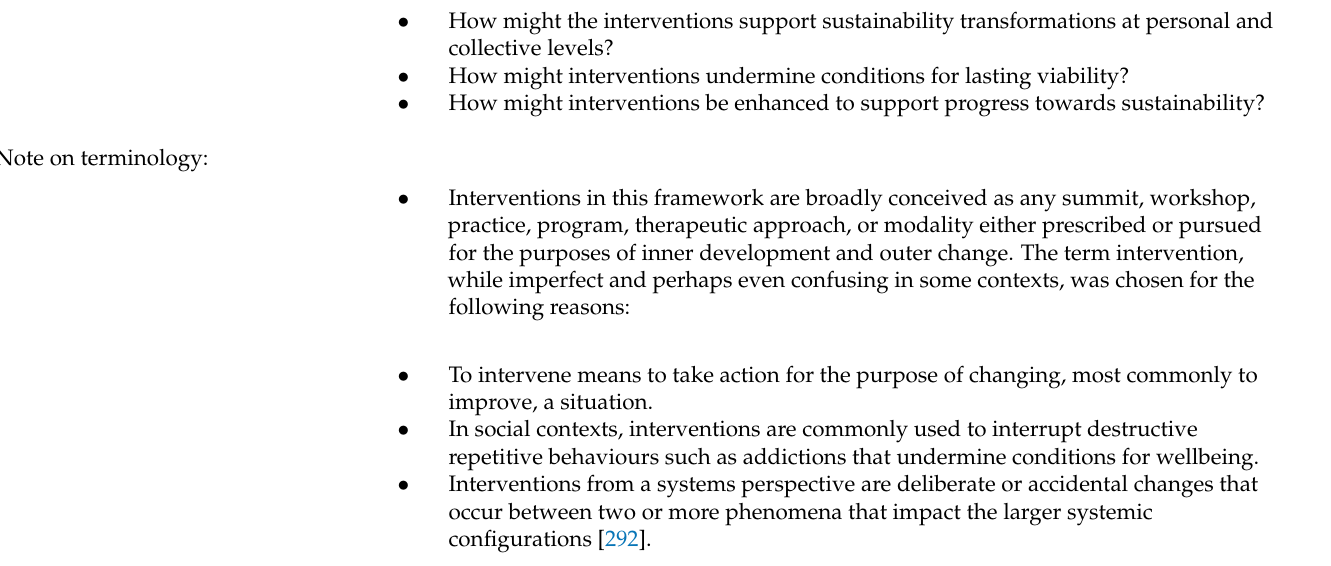
Table 4. Integration of basic assessment criteria for assessing interventions at the nexus of inner- outer